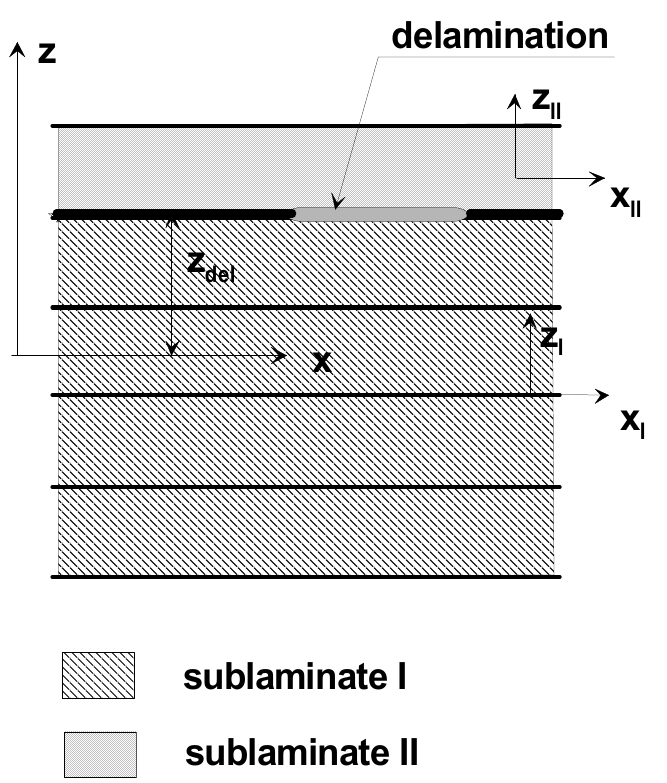
Figure 4. Geometry and location of the embedded delamination.